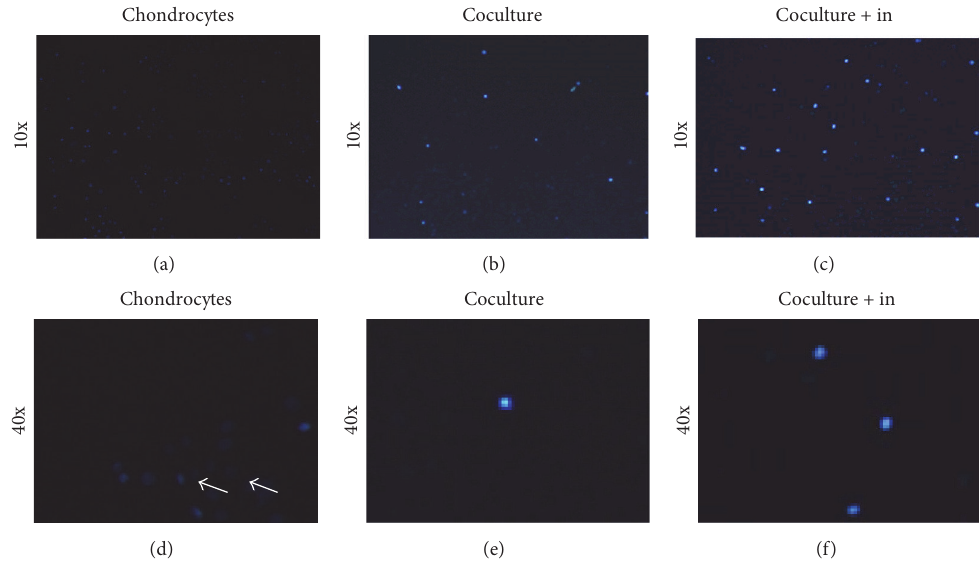
Figure 10: Effect of TGF- 𝛽 1 inhibitor on apoptosis analysis of chondrocytes cultured in three different conditions for 5 days determined by Hoechst 33258 staining. ((a), (d)) Chondrocytes were cultured in normal medium (chondrocytes). ((b), (e)) Chondrocytes were cocultured with ADSCs (coculture). ((c), (f)) Chondrocytes were cultured with ADSCs and TGF- 𝛽 1 inhibitor (coculture + in). Many apoptosis cells were found in chondrocytes cultured in normal medium ((a), (d)); however, ADSCs coculture system inhibited the apoptosis of chondrocytes ((b), (e)). The inhibition effect of ADSCs on apoptosis was blocked by TGF- 𝛽 1 inhibitor ((c),